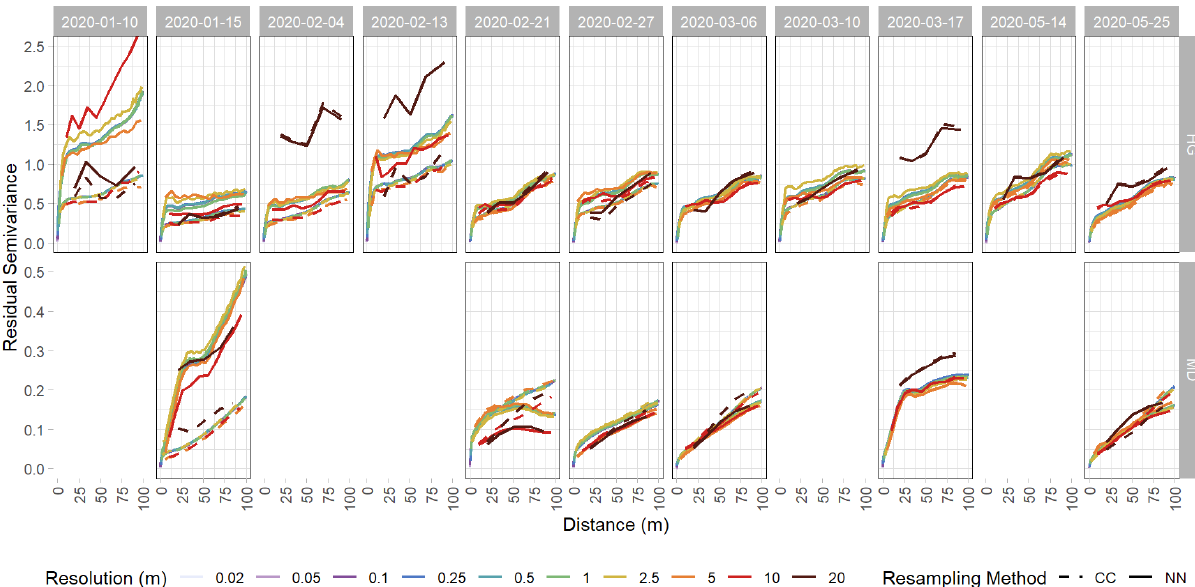
Figure A3. Experimental variograms of detrended snow depth residuals from the Hourglass (HG) and the meadow (MD). Each panel depicts a specific observation day, with solid lines representing nearest-neighbor (NN) resampling methods, dashed lines representing cubic- convolution (CC) resampling methods, and colors representing different snow depth DSM resolutions. Five observation days were removed from the meadow site time series due to poor model quality. Note different y axis scales for the HG and MD